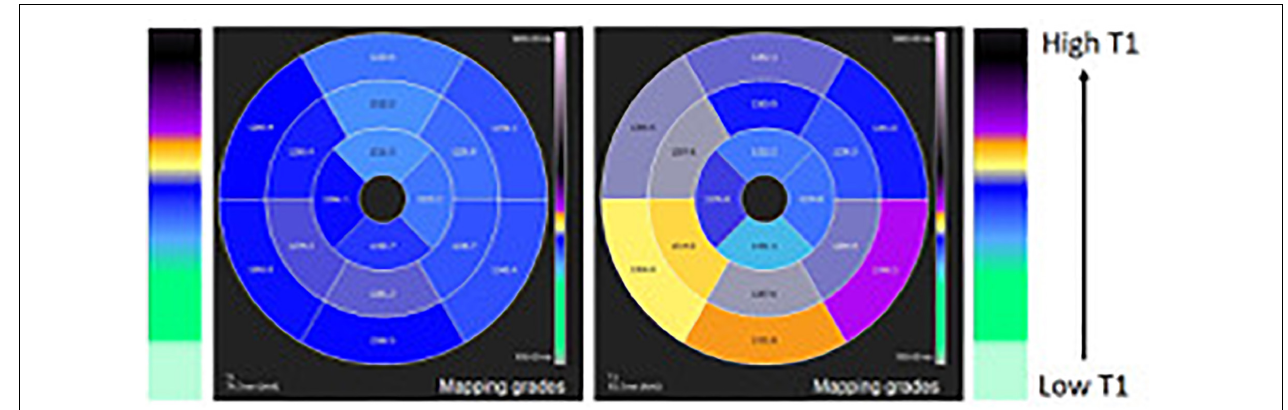
FIGURE 4 | T1 mapping of the left ventricle 16 segment-model polar map comparing a normal case (left panel) and a case with higher T1 in the inferior wall due to inflammatory process (right panel) .